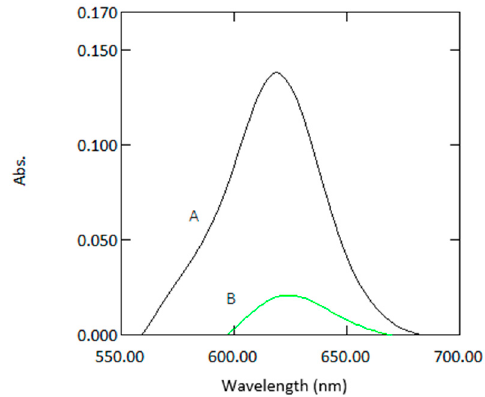
Figure 2. Absorption spectra of a sample containing 1 µ g mL − 1 arsenic with reagents measured in 10 mm cuvettes (A) and 1 mm quartz cuvettes (B) against reagent blank. Table 1. Average absorbance values for arsenic samples (0.2–1 μ g mL − 1 ) analyzed in two different types of cuvettes. Abs 1, SD 1 and % RSD 1 show the data for measurements carried out with 10 mm quartz cuvettes. Abs 2, SD 2 and % RSD 2 show the data for measurements in 1 mm quartz cuvettes. All measurements were carried out in triplicate ( n = 30).